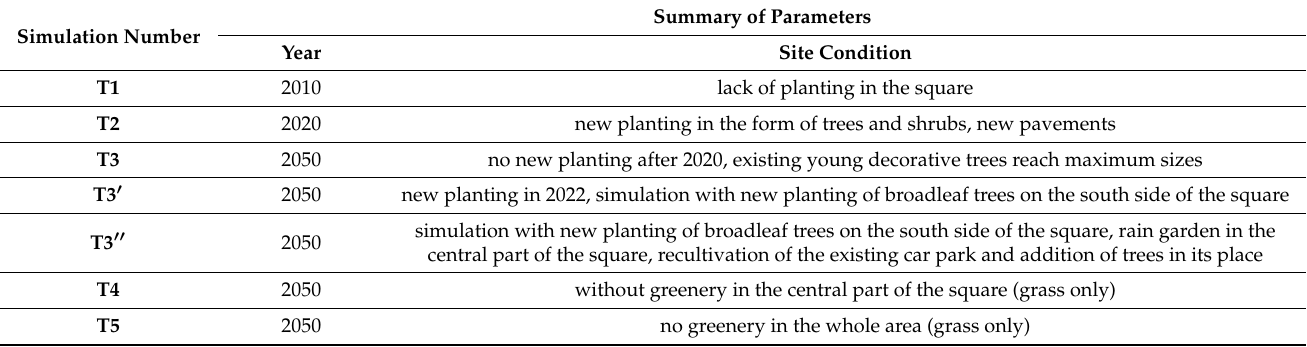
Table 4. Summary of simulation